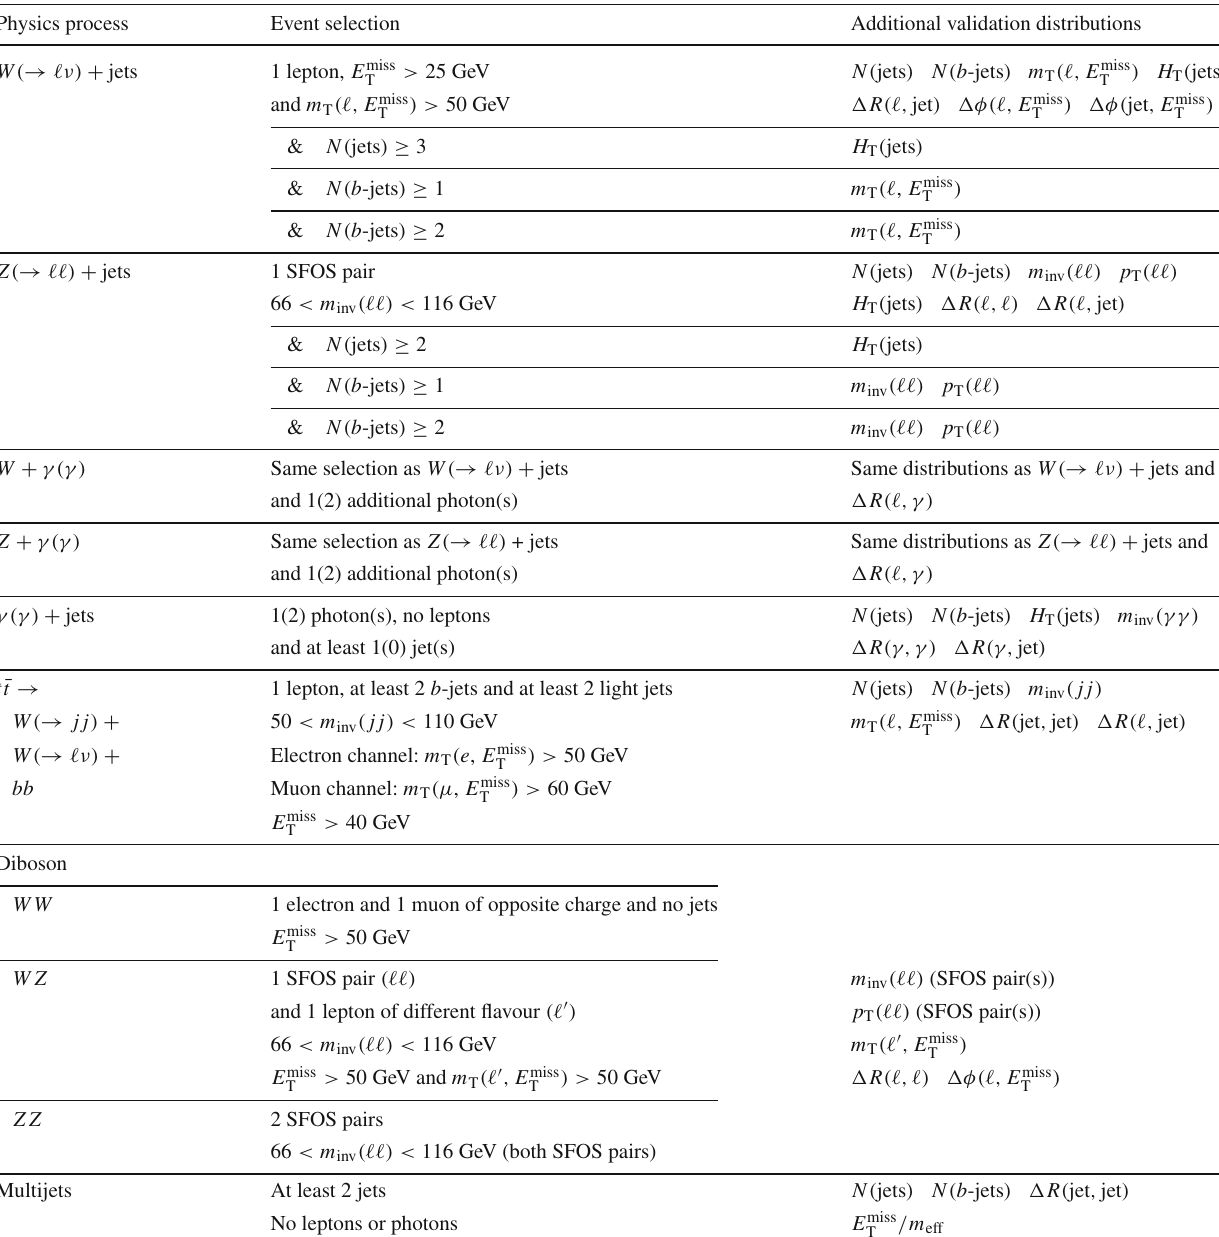
( 1 − cos (cid:9)φ((cid:12), E miss )) ] 1 / 2 . N (( b - ) jets ) is is defined as [ 2 p T ((cid:12)) E miss T T the number of ( b -)jets in an event. For the distance variables (cid:9) R and (cid:9)φ ,thetwoinstancesoftheobjectswiththeminimumdistancebetween ) , p ((cid:12)(cid:12)) and m them are used. The H T ( jets ) , m T ((cid:12), E miss T inv validation T distributions are evaluated in restricted ranges where large new-physics contributions have been excluded by previous direct searches. Same- flavour opposite-charge sign lepton pairs are referred to as SFOS ) )which T